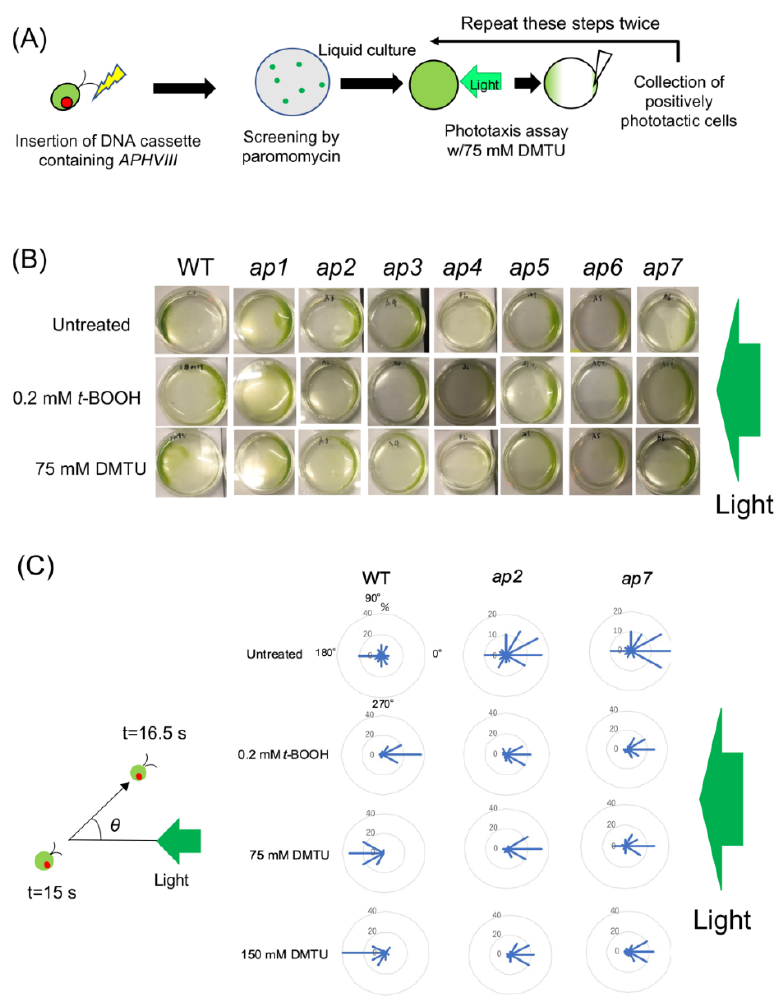
Figure 1. Isolation of ap mutants. ( A ) Schematics showing the screening methods for ap mutants. After introducing the pSI103-1 vector containing the APHVIII gene that confers paromomycin resistance, transformants were inoculated onto the selection agar plate. After collecting colonies, transformant cells (a mutant library) were subjected to phototaxis assay after treatment with 75 mM DMTU that strongly induces negative phototaxis. Cells showing positive phototaxis were collected, cultured again, and subjected to the second phototaxis assay. A mutant constantly showing positive phototaxis was isolated from a library and named ap mutant. ( B ) Phototaxis of WT and ap mutant cells. Cells were put in a Petri dish, and green light was illuminated from the right side. WT cells showed negative phototaxis without any treatment, positive phototaxis after treatment with 0.2 mM t -BOOH, and negative phototaxis after treatment with DMTU. The ap mutants showed positive phototaxis in any condition. ( C ) (Left) Schematic of cell-level phototaxis assay. Cell swimming angle ( θ ) was measured for 1.5 s following 15 s of illumination with a green LED. (Right) Cell-level phototaxis assay of WT and representative ap mutants, ap2 and ap7 . Polar histograms depicting the percentage of cells moving in a particular direction relative to light illumination from the right (12 bins of 30°; n = 30 cells per condition). Cells were observed after treatment with no reagent (top), 0.2 mM t -BOOH to induce positive phototaxis (second from the top), 75 mM (third from the top), or 150 mM DMTU to induce negative phototaxis (bottom).